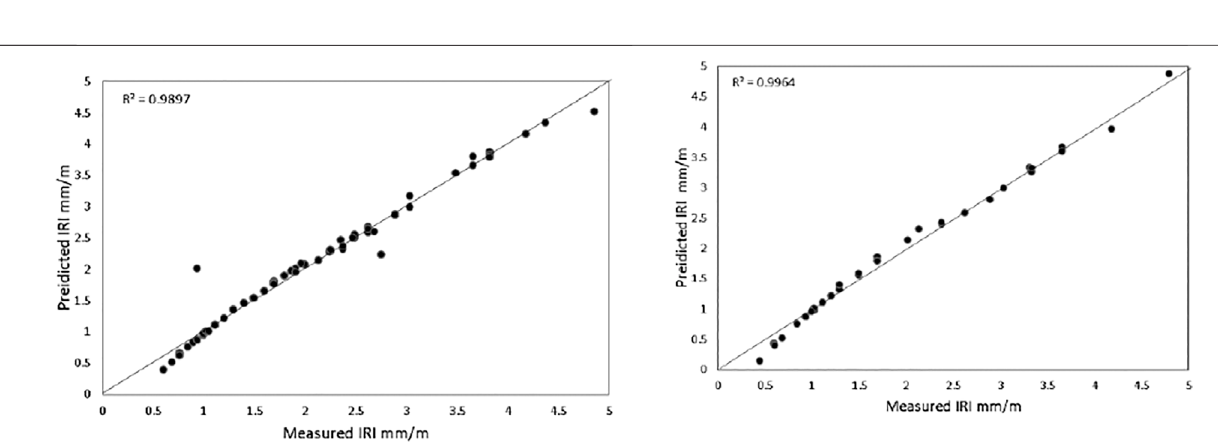
FIGURE 6 | Correlation of the predicted PCI versus measured PCI for testing and training data.